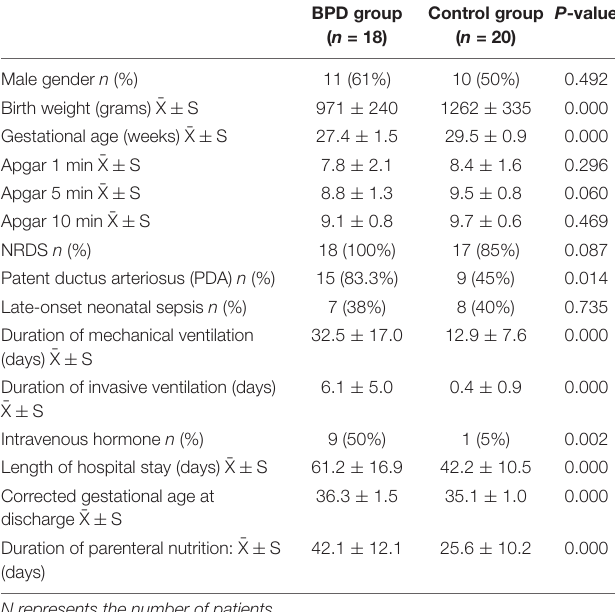
TABLE 1 | The basic infant characteristics between the BPD and control groups.